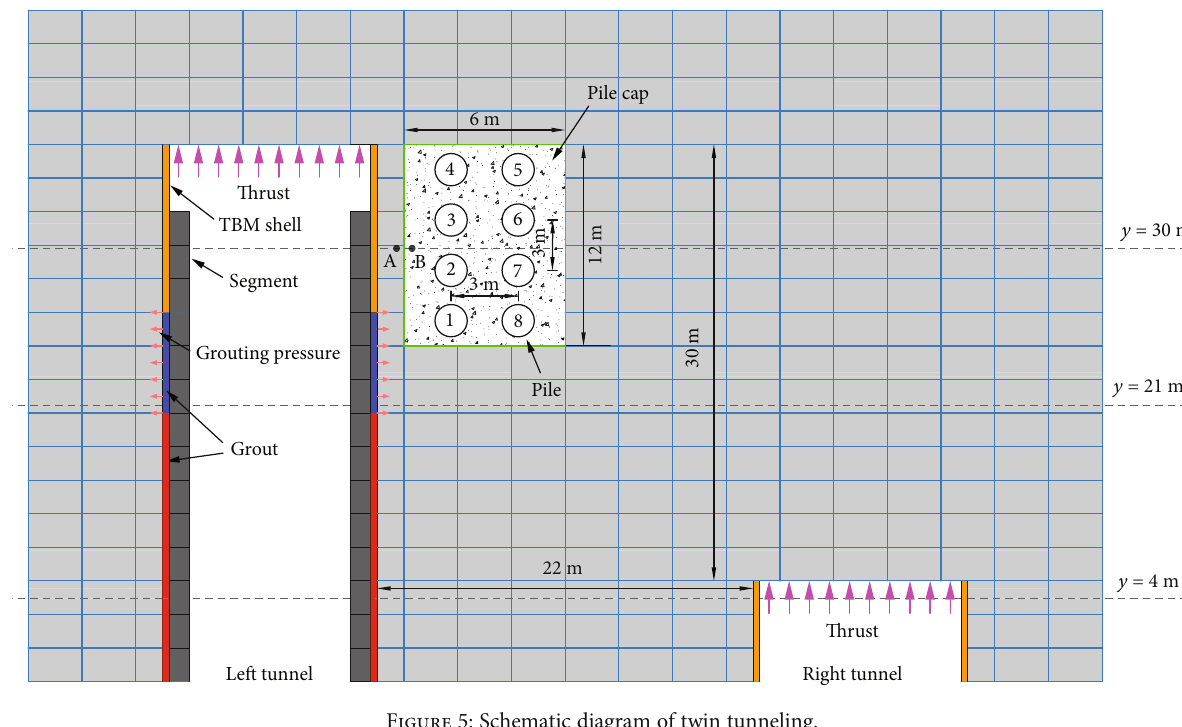
Figure 5: Schematic diagram of twin tunneling.